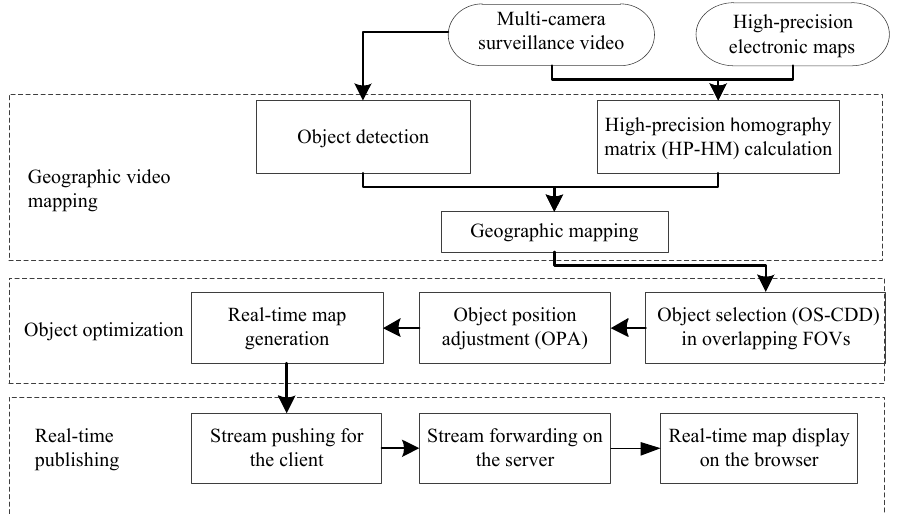
Figure 1. Flowchart of the RTWM-HP method.